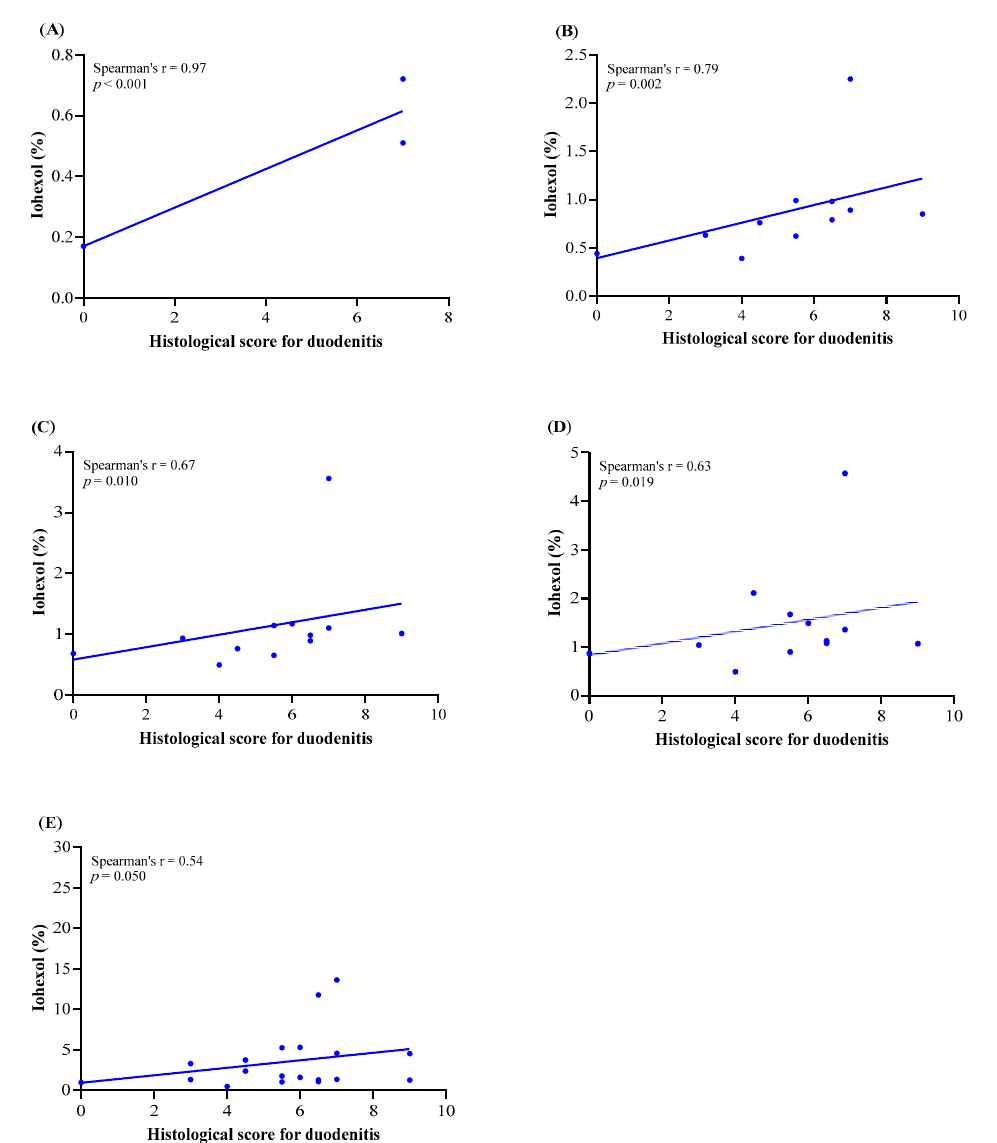
Figure 7. Spearman’s rank correlation coefficient between the histological score for duodenitis and the urinary excretion of iohexol in time periods ( A ) 0–2 h, ( B ) 0–4 h, ( C ) 0–6 h, ( D ) 0–12 h and ( E ) 0–15 in treated male mice in Week 5.